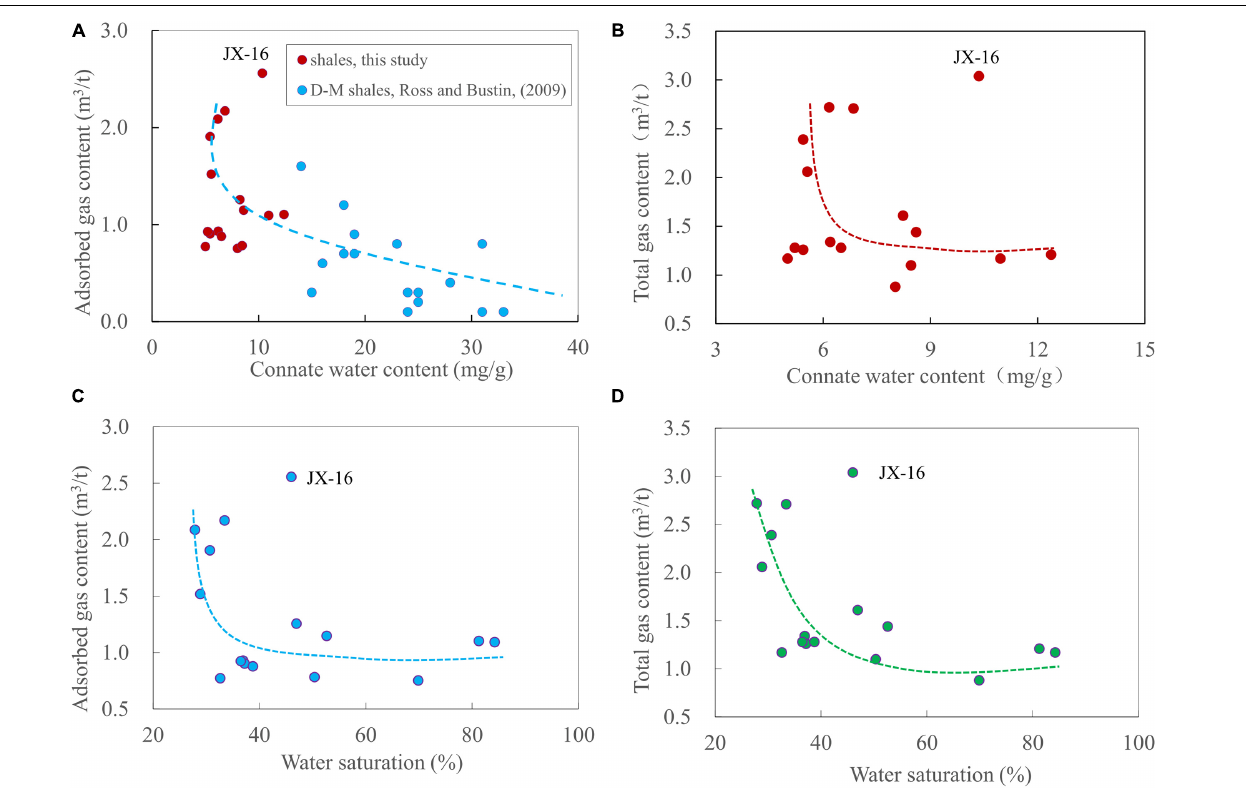
FIGURE 11 | Plots showing the relationships of irreducible water contents with the Q ads (A) and Q total (B) , and the correlations of the S W with the Q ads (C) and Q total (D) . The D-M shale data were measured at 30 ◦ C (Ross and Bustin, 2009). It should be noted that, since the sample JX-16 is away from the trend of the regression line, the regression line have not included the data of this